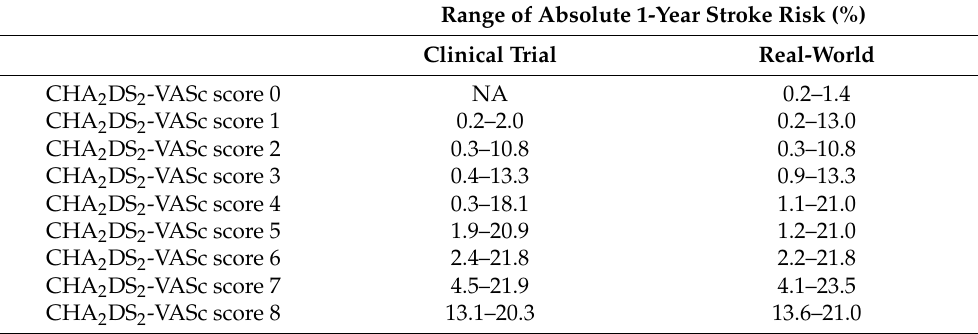
Table 2. Range of absolute 1-year stroke risk stratified by CHA 2 DS 2 -VASc score in clinical trials vs. the real-world.